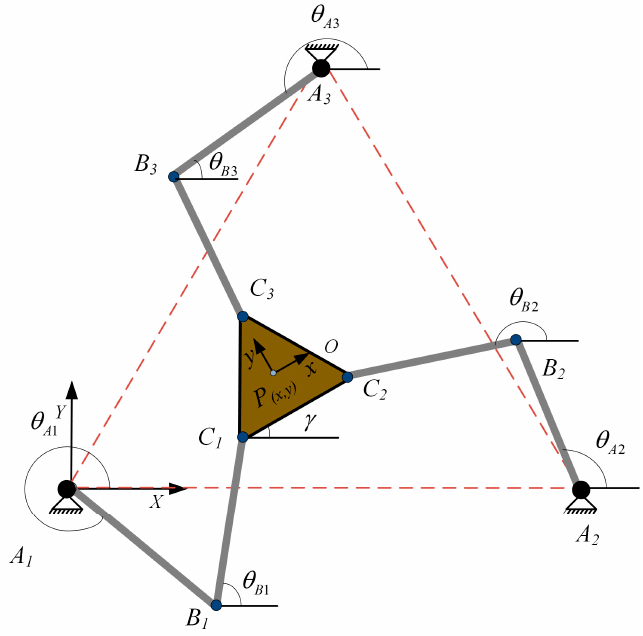
Figure 2. Diagram of the 3-RRR parallel robot.